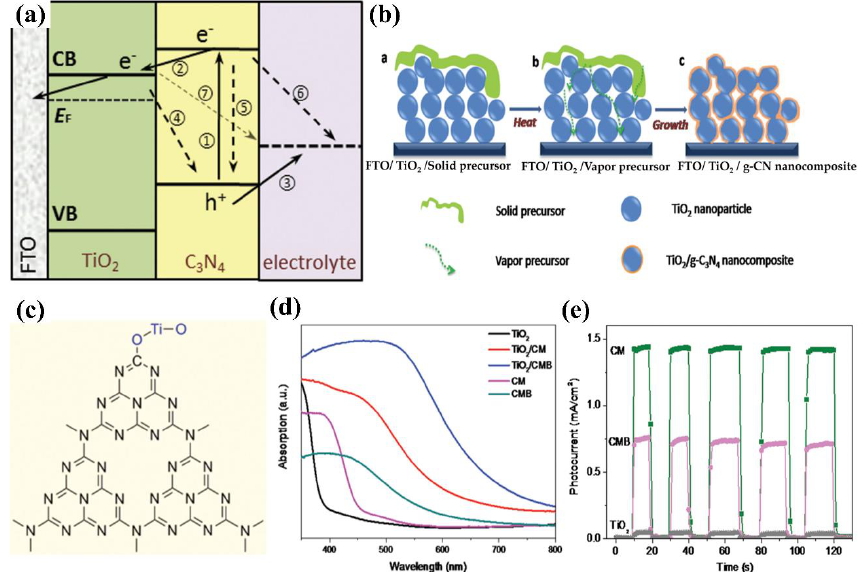
Figure 17. ( a ) Schematic illustration of charge transfer mechanism of type (II) TiO 2 /g − CN photo- electrode (paths 1, 2, and 3, charge excitation and transfer; paths 4, 5, 6, and 7, charge